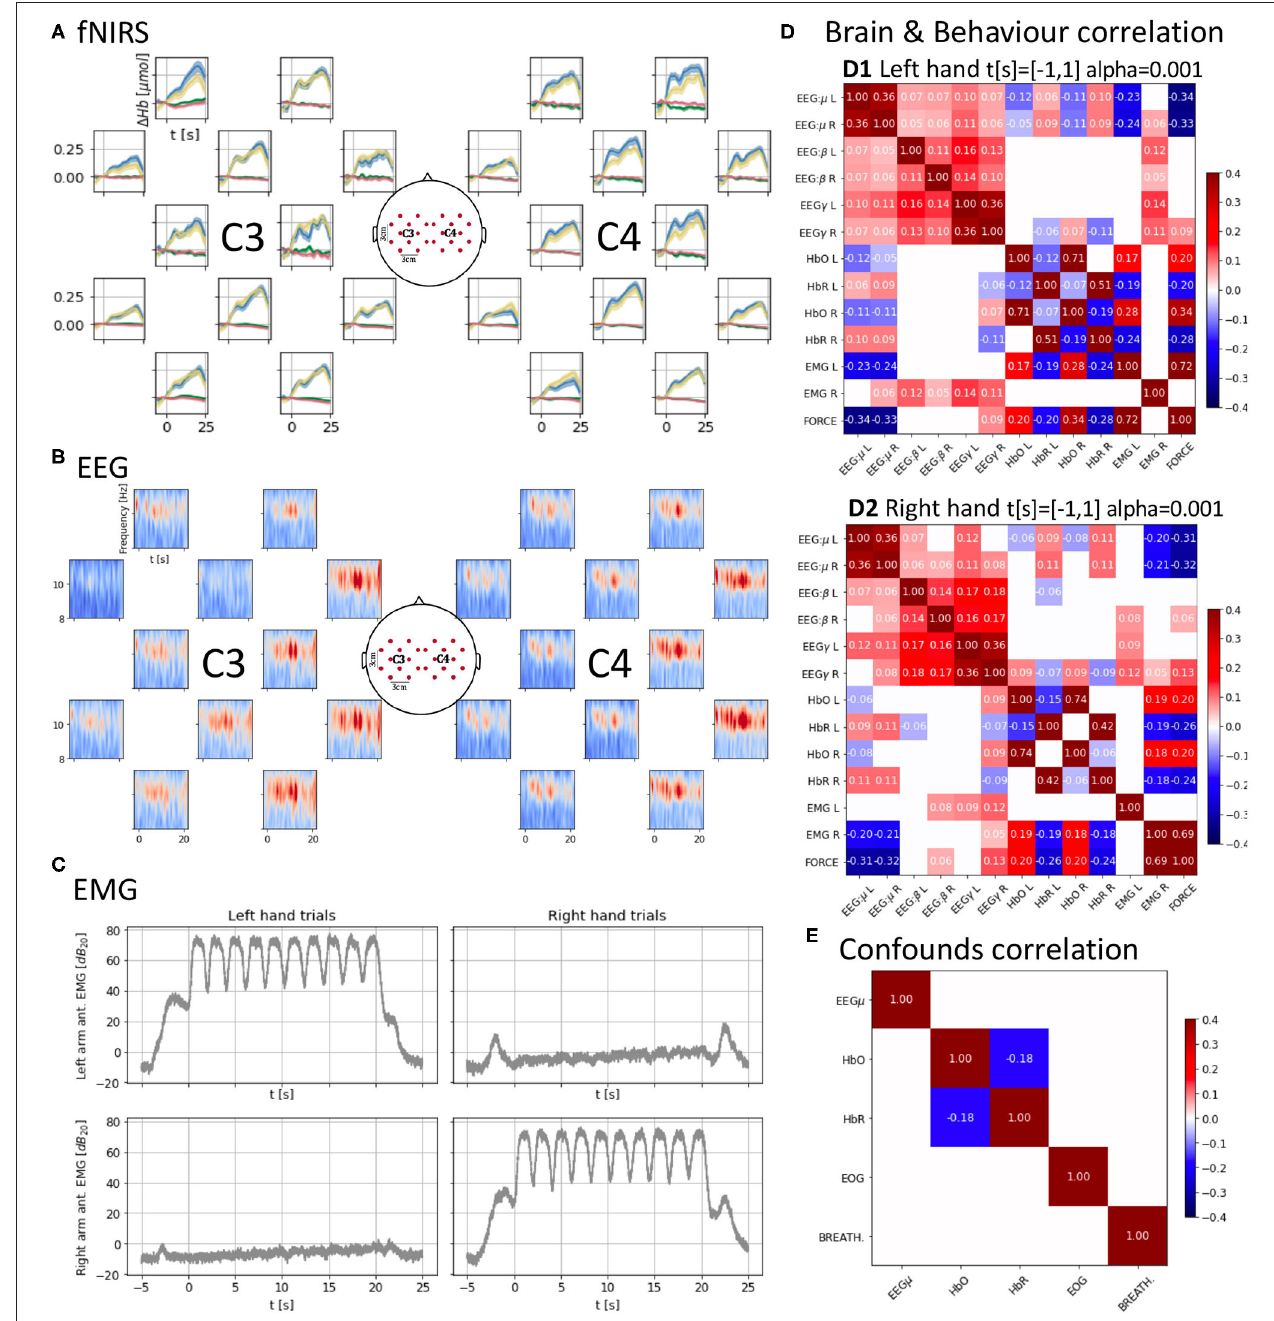
FIGURE 2 | (A) Cross-subject average of HbO and HbR changes across trials, time-locked to the “Go” cue ( t = 0 s) of each trial. Each trial consists of 10 contraction/relaxation periods (21 s of activity starting at the “Go” cue). HbO increases during the task and HbR decreases at a smaller scale, both start returning to baseline after the 21 s of activity. Units in top-left. (B) Cross-subject mu-band spectrogram averaged across right-hand trials as in (B) . Periodic desynchronizations can be observed. Units in top-left. (C) Averaged EMG spectral density across trials as in (A,B) showing similar power density for the active muscles controlling the hands. (D) Brain and behavior correlation matrix computed on the force onset ( − 1 s to 1 s around the “Go” cue) showing only significant ( p < 0.001) correlations. It shows a contralateral change in correlation values between HbO and HbR and force and the time-locked mu desynchronization event represented as the negative correlation between force and the EEG mu power band. (E) Confounds correlation matrix showing only significant ( p < 0.001) correlations computed along the task ( t = [ − 1,20] s around the “Go” cue) for the right hand condition. Correlations between brain signals and confounds are non-significant ( α = 0.001).